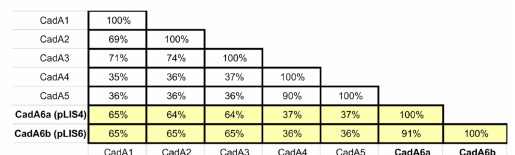
Figure 3. Percentage amino acid sequence identity (pairwise) of di ff erent CadA cadmium resistance determinant variants: CadA1 (GenBank acc. no. WP_003728466.1), CadA2 (WP_003726381), CadA3 (WP_010989665.1), CadA4 (WP_003744464.1), CadA5 (WP_047584121.1), CadA6a (plasmid pLIS4) and CadA6b (plasmid pLIS6).